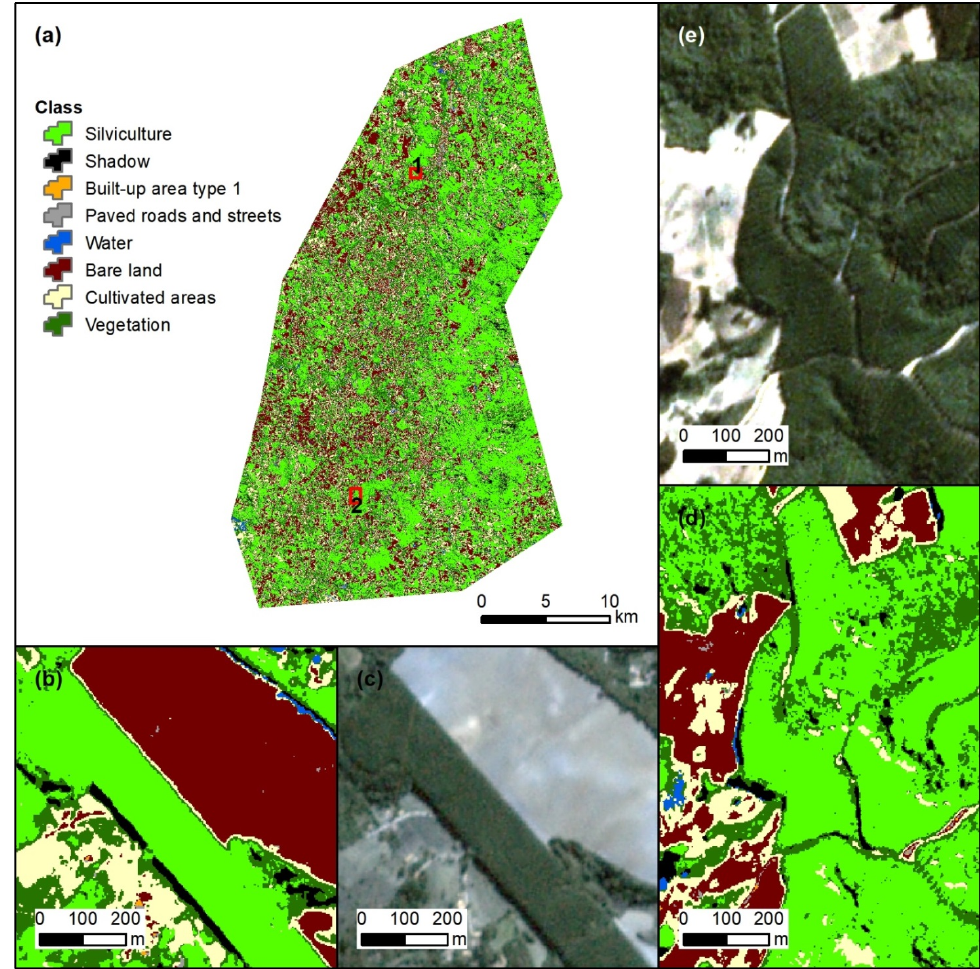
Figure 5. Example of PlanetScope image classification with best validation results for the rural sites (S3). ( a ) Global view; ( b , c ) Classification and true-color composition of source image for Sub-area 1 (red rectangule in a); ( d , e ) Classification and true-color composition of source image for Sub-area 2.